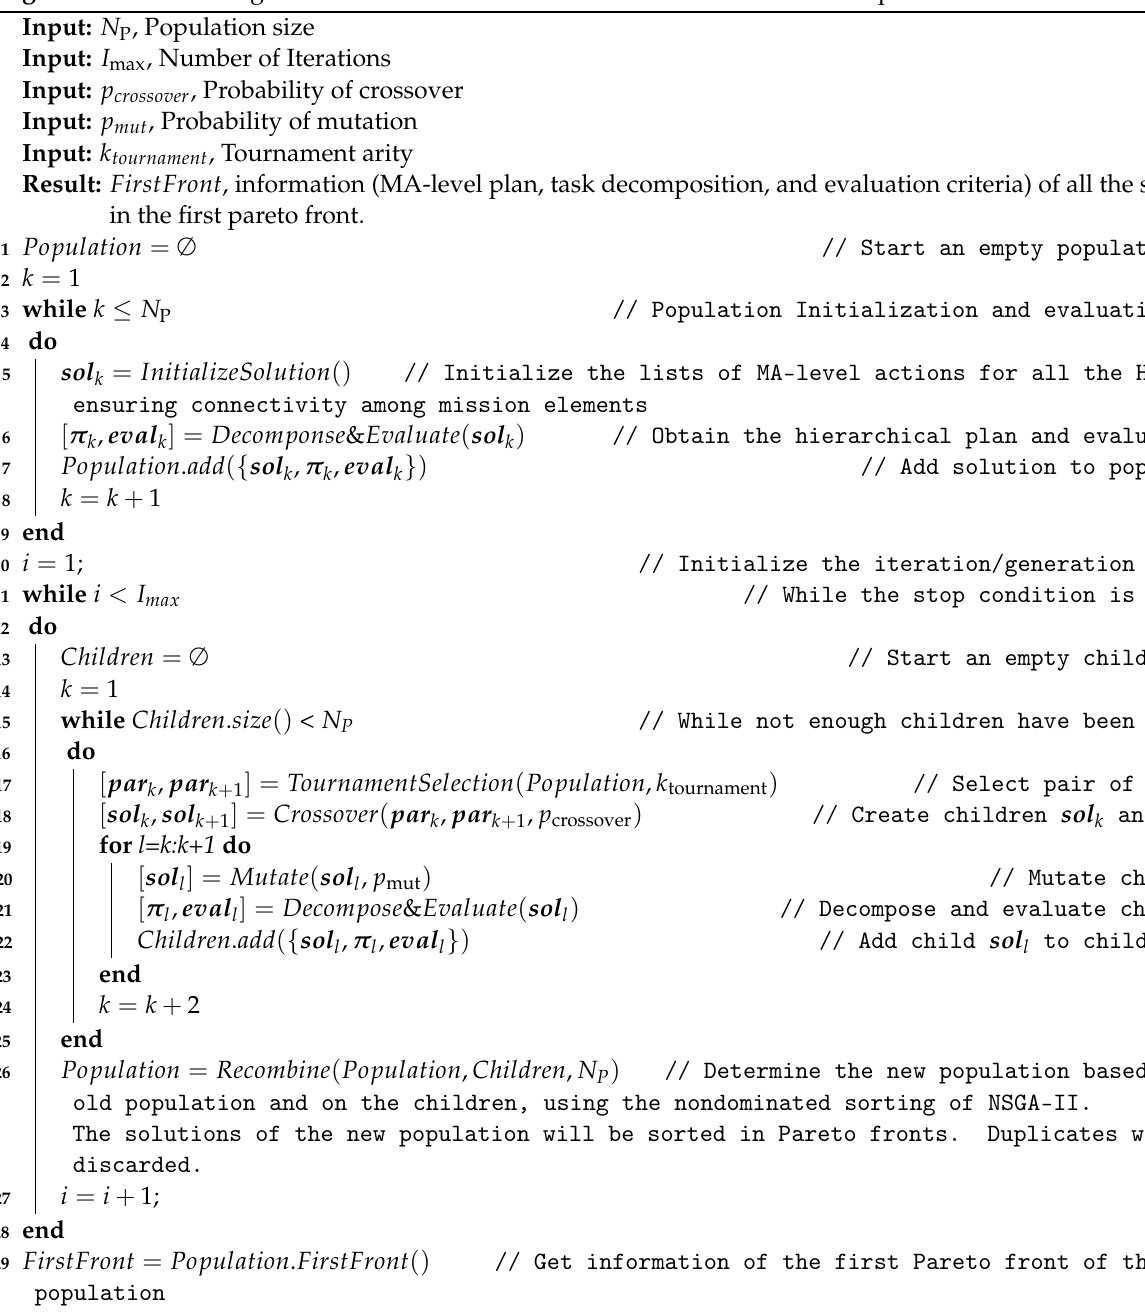
Algorithm 2: NSGA-II-guided search of nondominated solutions of hierarchical